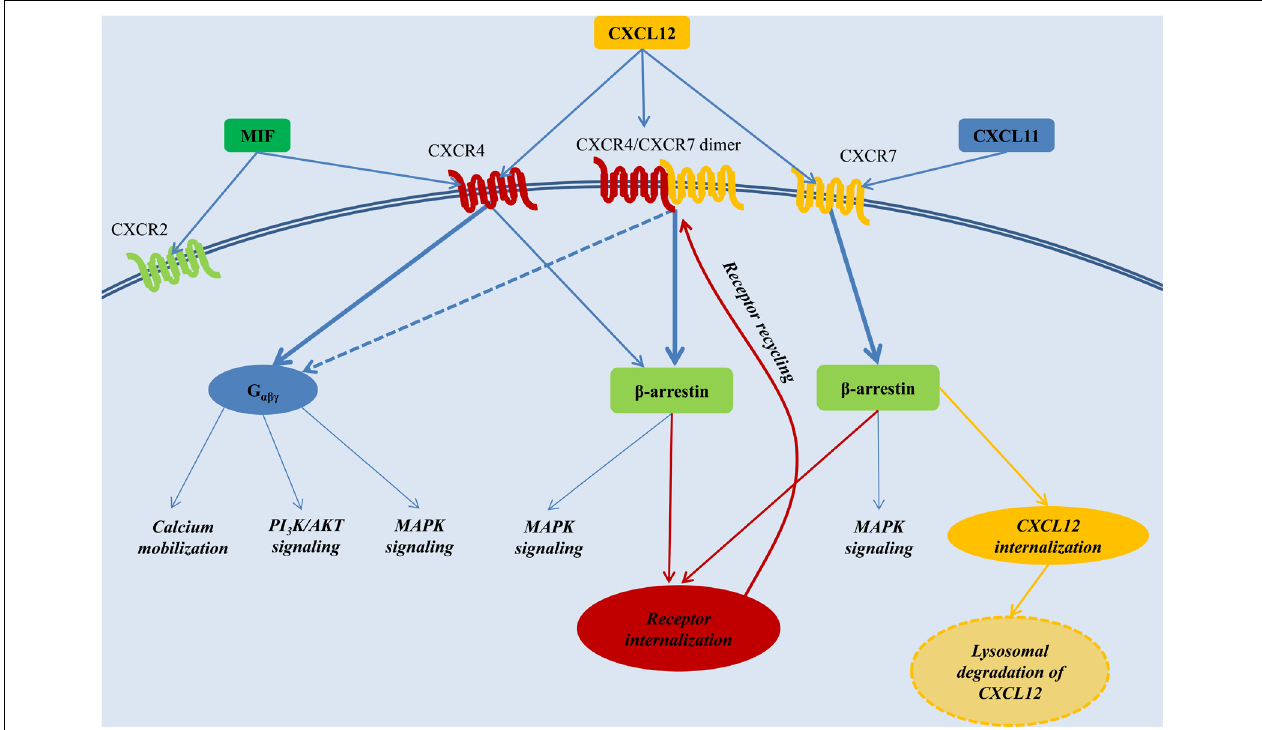
FIGURE 2 | The CXCL12 signaling network. CXCL12 employs two distinct receptors, CXCR4 and CXCR7. CXCR4 additionally acts a receptor for MIF, whereas CXCR7 can also bind CXCL11. Generally, stimulation of CXCR4 triggers preferentially G-protein-coupled signaling, whereas activation of CXCR7 or the CXCR4/CXCR7 complex induces β -arrestin-mediated signaling. Internalization of the receptors CXCR4 and CXCR7, and